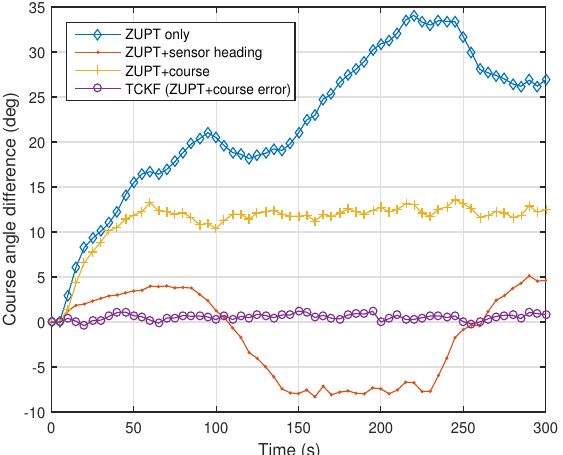
Figure 10. Root-mean-square (RMS) values of angle differences between course angles calculated from the left foot position and those from the right foot